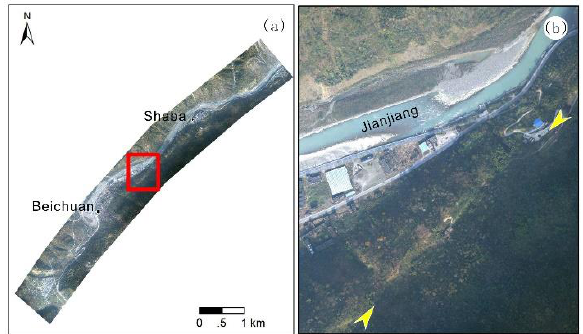
Figure 2. Mosaic image in study area. (a) Ortho image; (b) Zoomed image of red rectangle in (a).